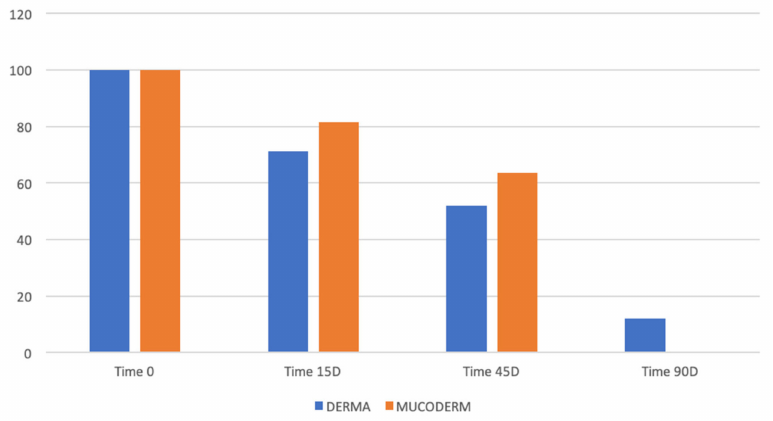
Figure 8. Comparison of matrix resorption between dADMG and mADMG hADMG and pADMG grafts.